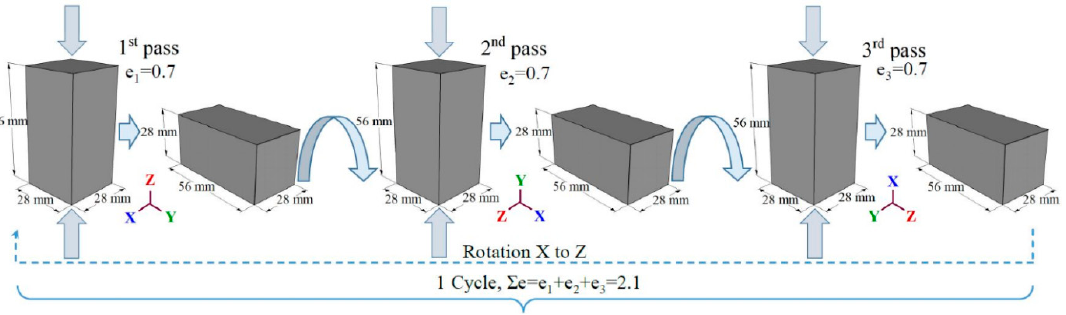
Figure 2. The scheme of sample rotation during isothermal multidirectional forging.